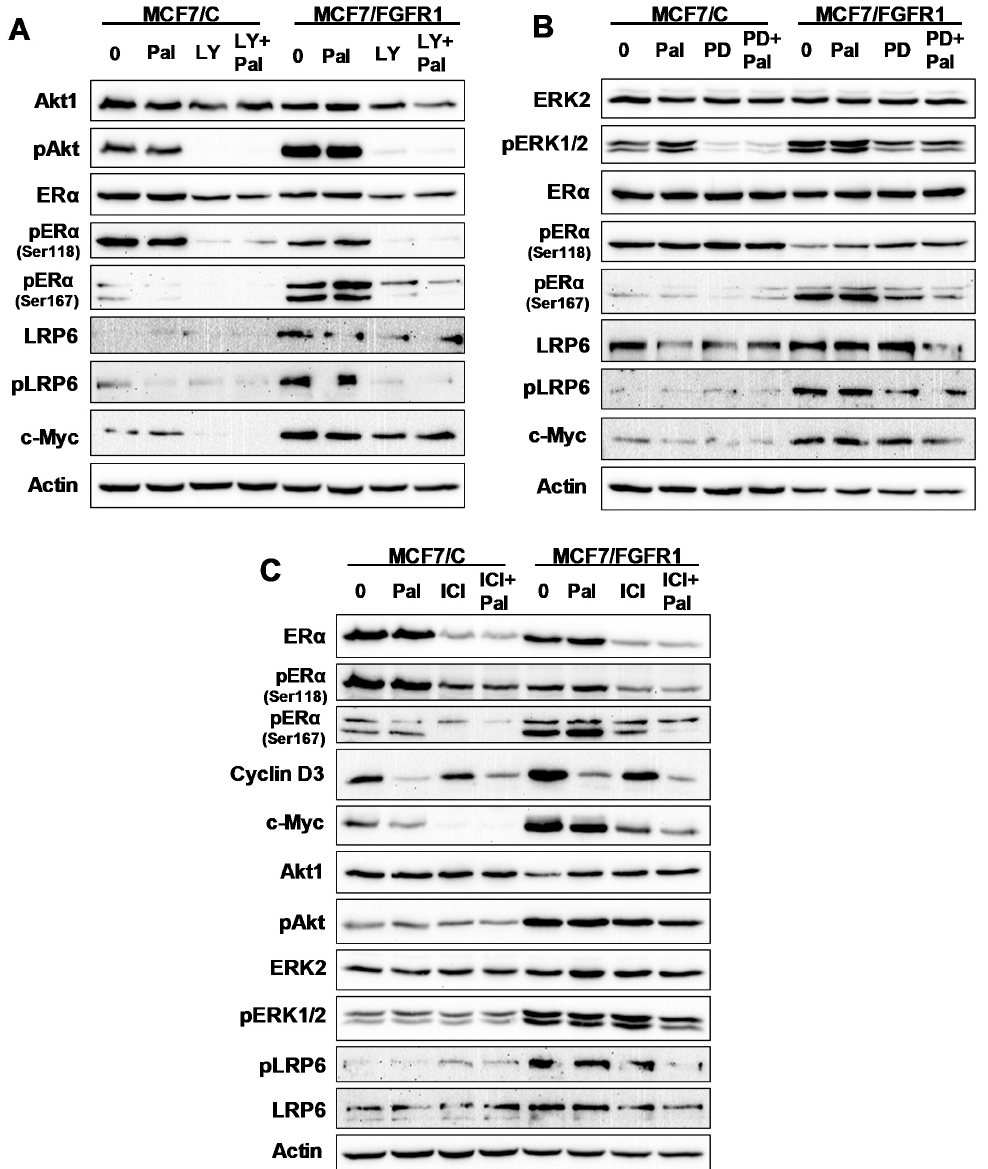
Figure 7. Effect of inhibitor targeting PI3K/Akt, MAPK/Erk, ER α , and LRP6 pathways on FGFR1 overexpression-induced signal transduction. PI3K/Akt targeting LY294002, MAPK/Erk targeting PD98059 and ER targeting fulvestrant/ICI 182,780 (ICI) were used for the tests. MCF-7/C and MCF-7/FGFR1 cells were treated with palbociclib (0, 5 μ M) and each specific inhibitor alone or in combination for 24 h, followed by Western blot analysis of specified markers. ( A ) The paired cell lines were treated with palbociclib and/or LY294002 (20 μ M); ( B ) the paired cell lines were treated with palbociclib and/or PD98059 (20 μ M); ( C ) the paired cell lines were treated with palbociclib and/or ICI (100 nM). Each panel was probed with the target of the specific inhibitor and other key markers of RTK, ER, and LRP6 signaling.